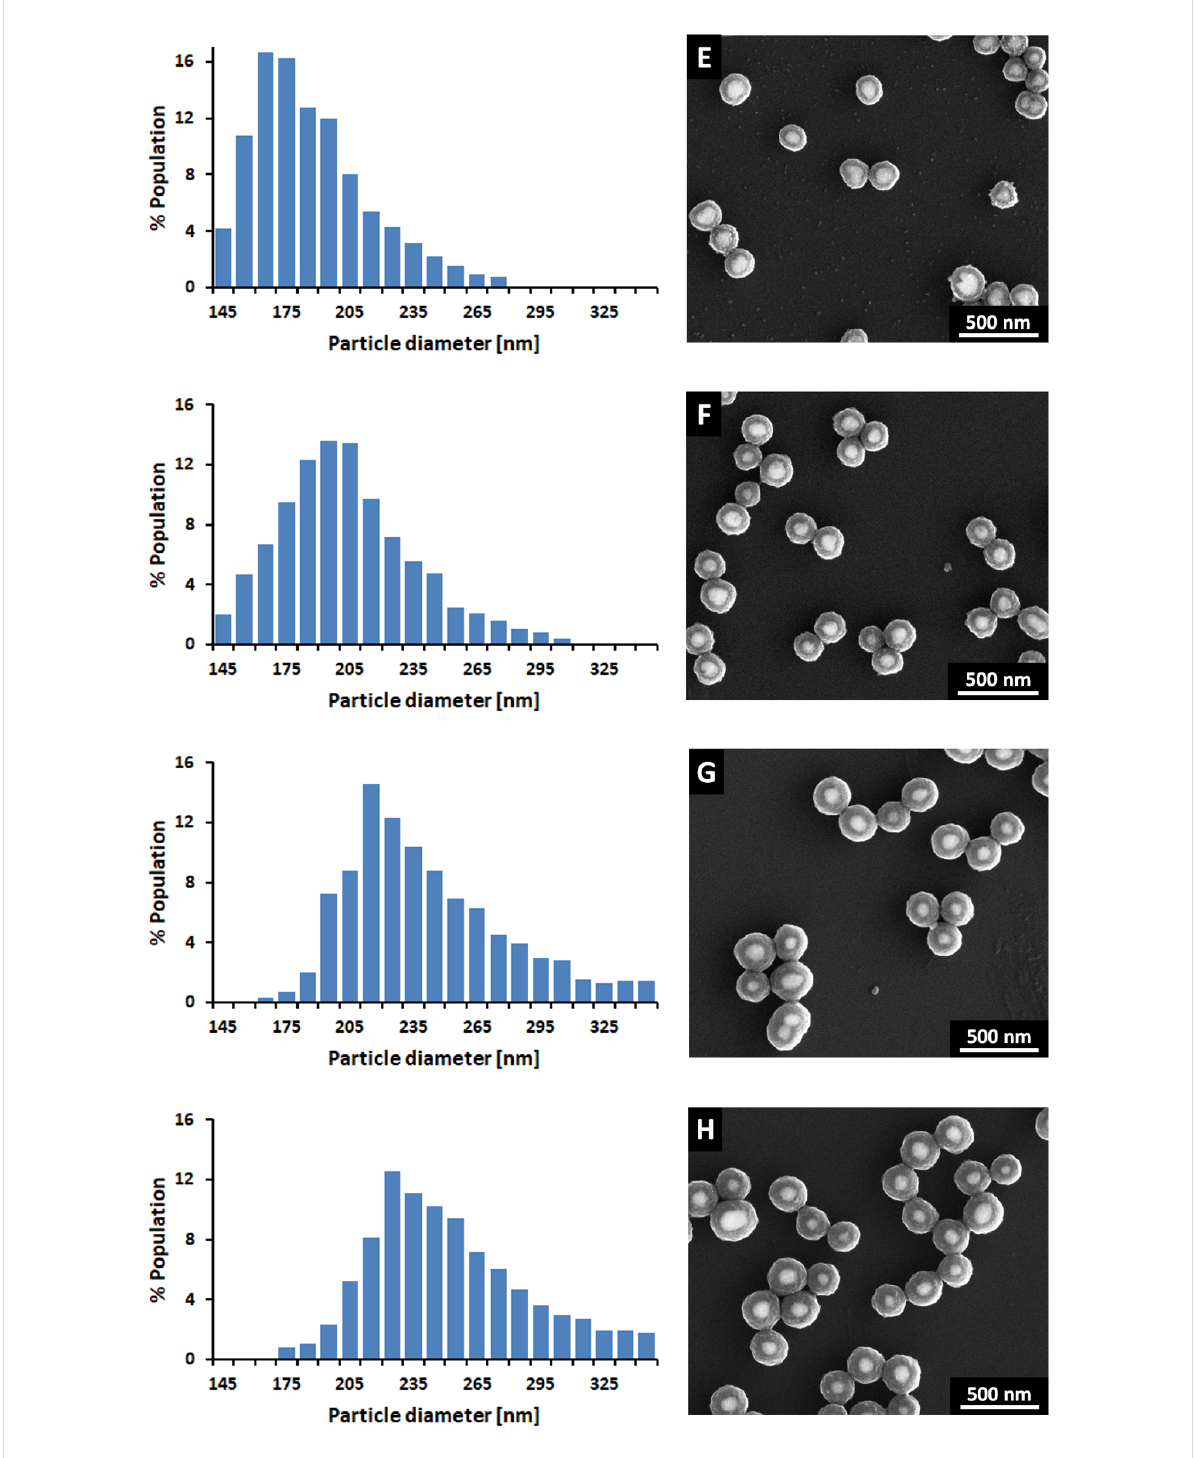
Figure 2: SEM images and TRPS size histograms of Ag@TiO 2 (Samples E–H) structures with various titania shell thicknesses (see Table 1).